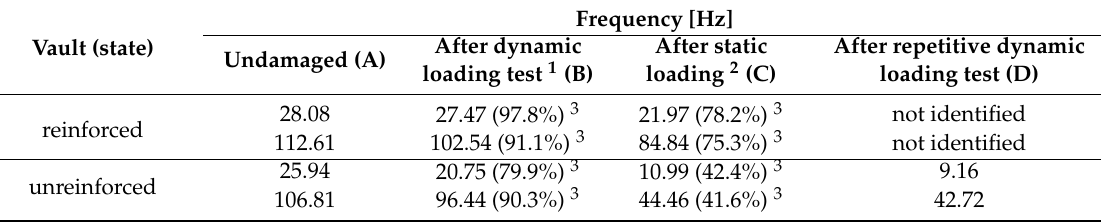
Table 3. Identified resonant (natural) frequencies of tested